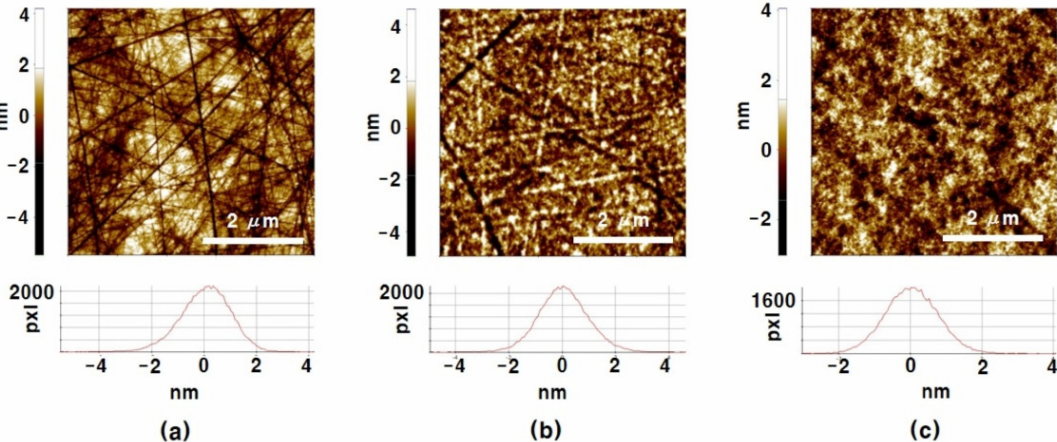
Figure 9. AFM results of the pristine and the etched SiC wafer surface. ( a ) The pristine SiC wafer and the etched wafer by the mixed gas filament plasma of He:NF 3 :O 2 ( b ) 1:1:3 and ( c ) 2:1:3 (slm:sccm:sccm) of 15 times of 6 mm by 6 mm raster scan etch at Va: 3